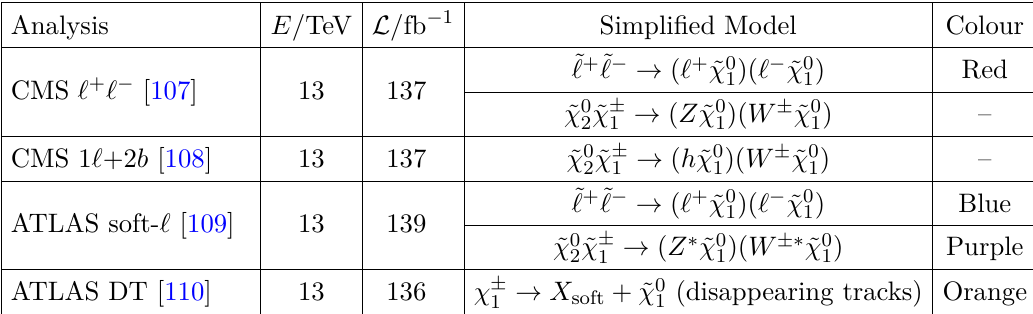
Table 2 . The experimental analyses and simplified models used in the inspection of a stable neutralino scenario. The colour indicates to the region where the simplified model limit provides 95% CL exclusion in figures 2, 3 and 4. The simplified models without designated colours did not give excluded regions in our parameter